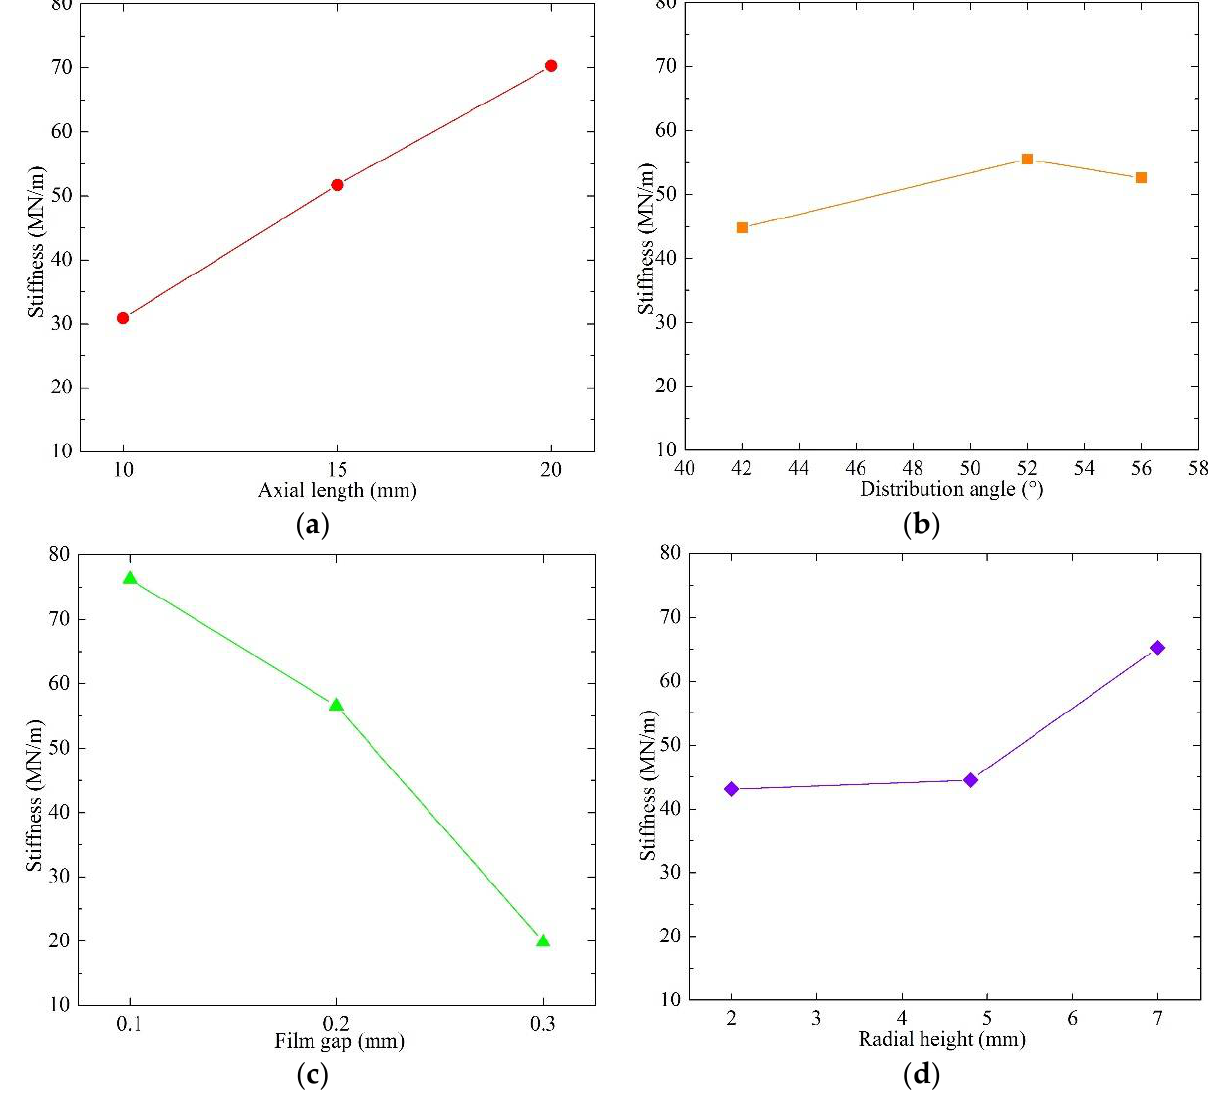
Figure 10. Main effect for stiffness: ( a ) Axial length; ( b ) Distribution angle; ( c ) Film gap; ( d ) Radial height. Table 2. ANOVA for